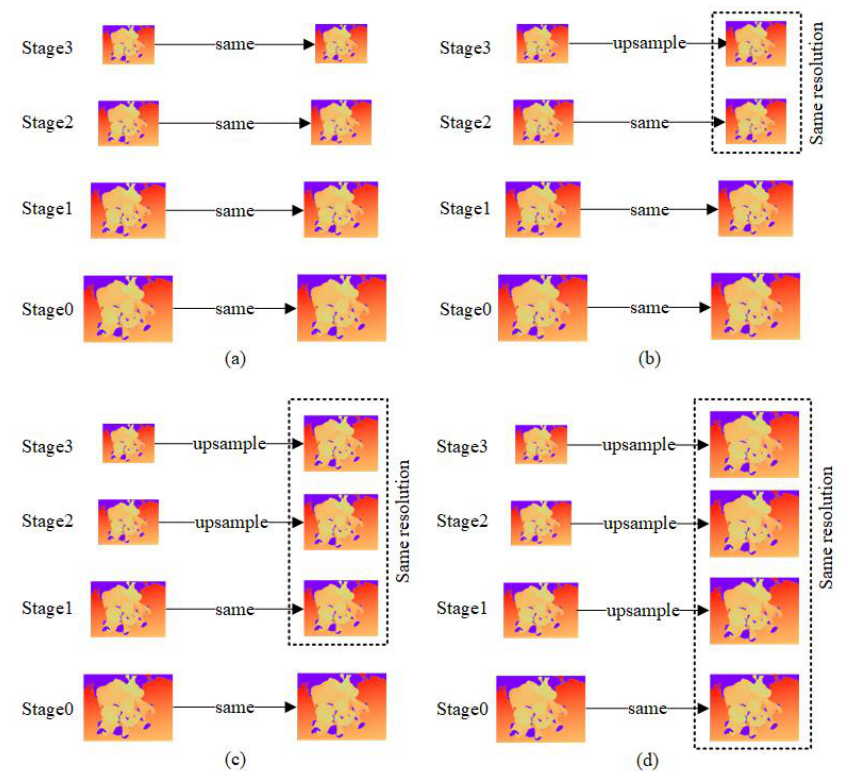
Figure 11. Different depth map adjustment methods. ( a ) The resolution of the depth map at each stage remained unchanged; ( b ) The resolution of the depth map at stage 3 is upsampled to the size of the depth map at stage 2. The resolution of the depth map from stage 0 to stage 2 remains the same; ( c ) The resolution of the depth maps at stage 2 and Stage 3 is upsampled to the size of the depth map at stage 1. The resolution of the depth map at stage 0 and stage 1 remains the same; ( d ) The resolution of the depth map from stages 1 to 3 is upsampled to the size of the depth map at stage 0. The resolution of the depth map at stage 0 remains the same.